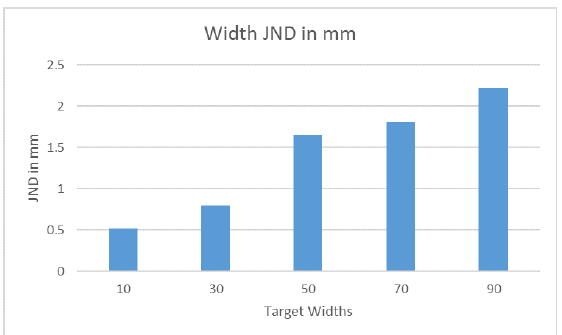
Figure 12. Just noticeable difference width in